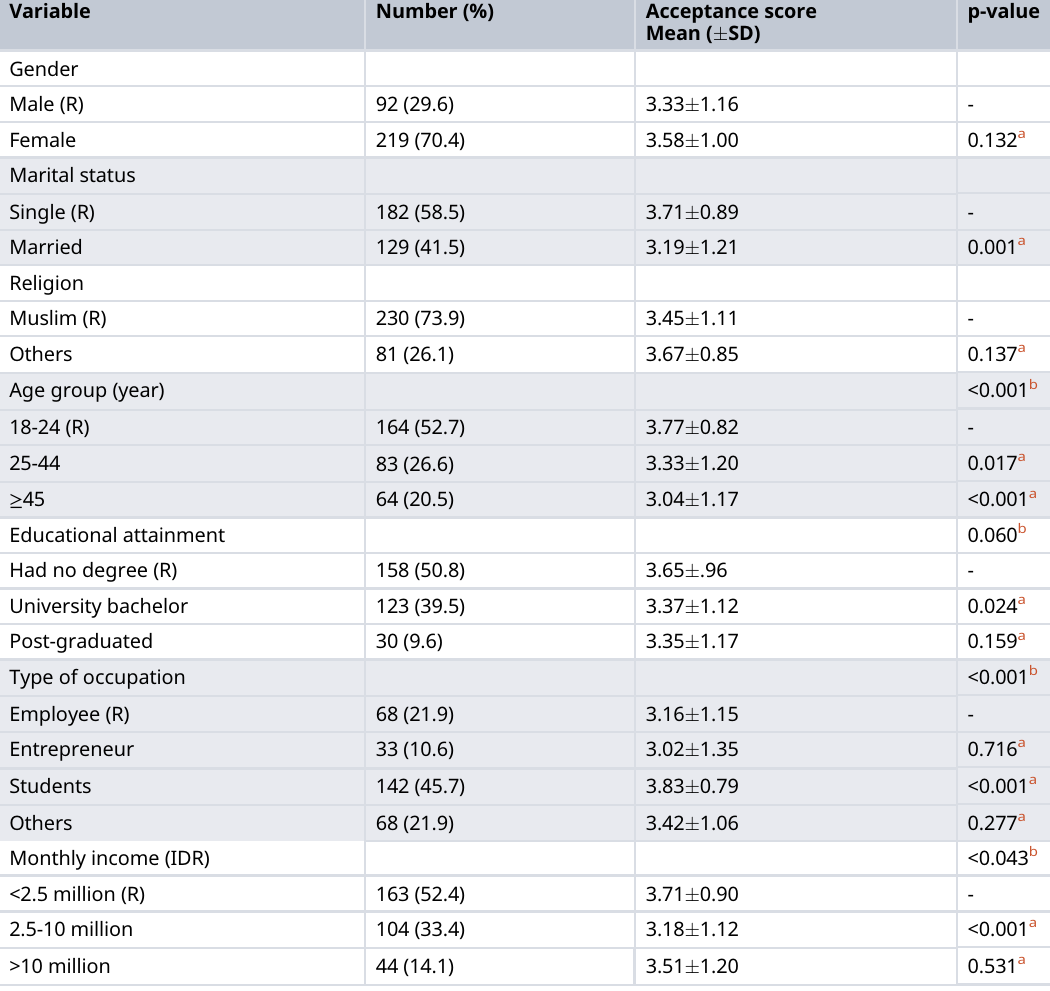
Table 5. Factor associated with score of acceptance for a COVID-19 vaccine (n =